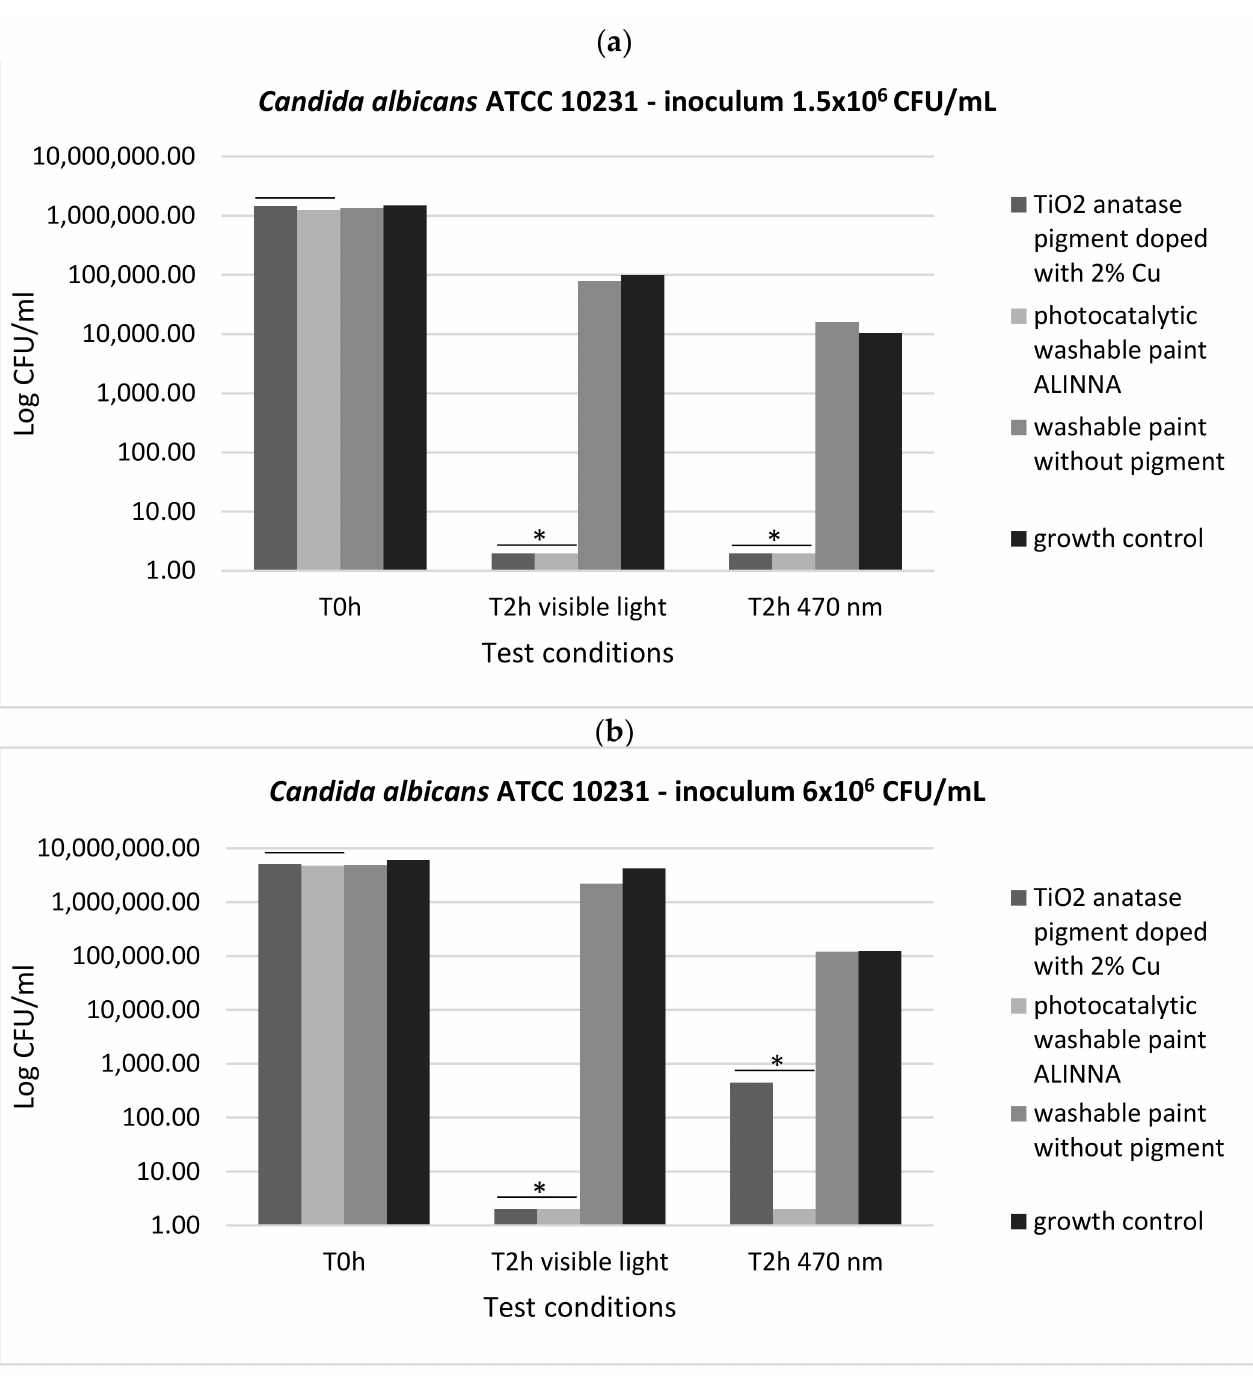
Figure 19. Graphical representation of the log10 values of colony-forming units (CFU)/mL representing the viable cells of C. albicans ATCC 10231 after the 2 h contact with tested products, in two conditions: blue light (470 nm) and visible light; ( a ) 1.5 × 10 6 CFU/mL tested yeast cell density; ( b ) 6 × 10 6 CFU/mL tested yeast cell density; * 0.05 ≥ p (T ≤ t) > 0.001 shows significant evidence of inhibitory effect manifested by doped pigment on bacterial growth and